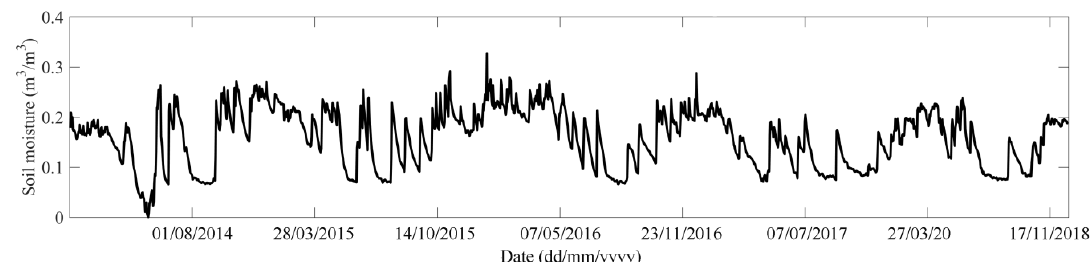
Table A2. Pearson correlation coefficient between the vegetation parameters. Vegetation Parameters